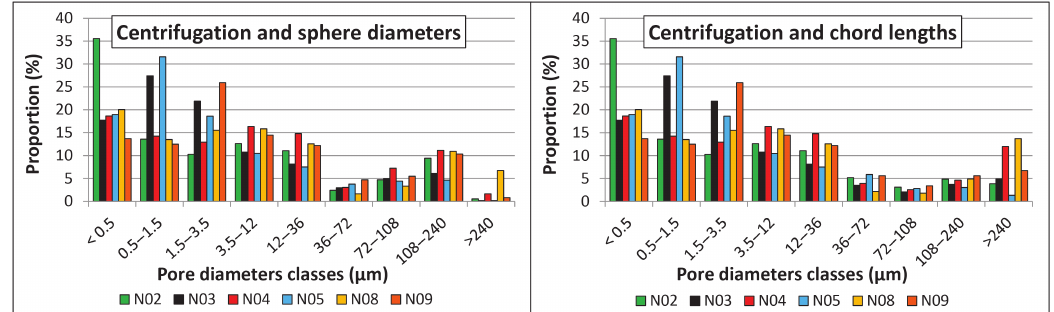
Figure 9. Pore diameters distributions from laboratory and XRMT calculations for Normandie rock type. Distribution from centrifugation and sphere diameters analysis is displayed on the left, while distribution from centrifugation and chord lengths analyses is shown on the